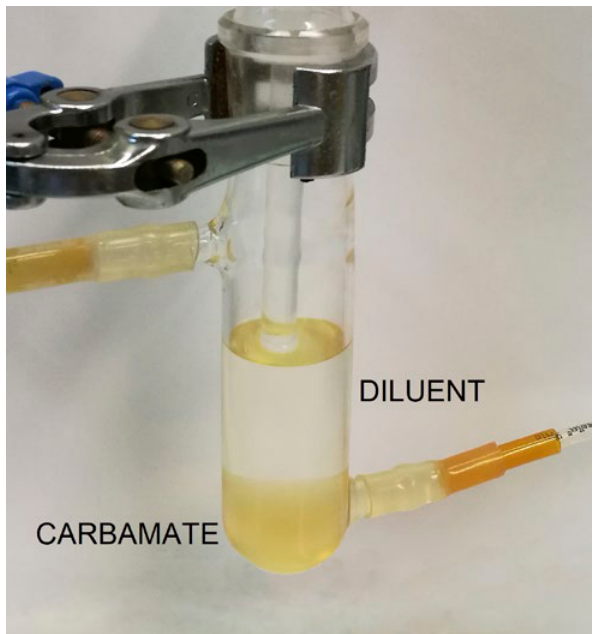
Figure 4. Two liquid phase recovered from CO 2 capture: the lower phase is the carbonated absorbent and the upper phase is predomi- nantly the diluent with a small amount of the amine